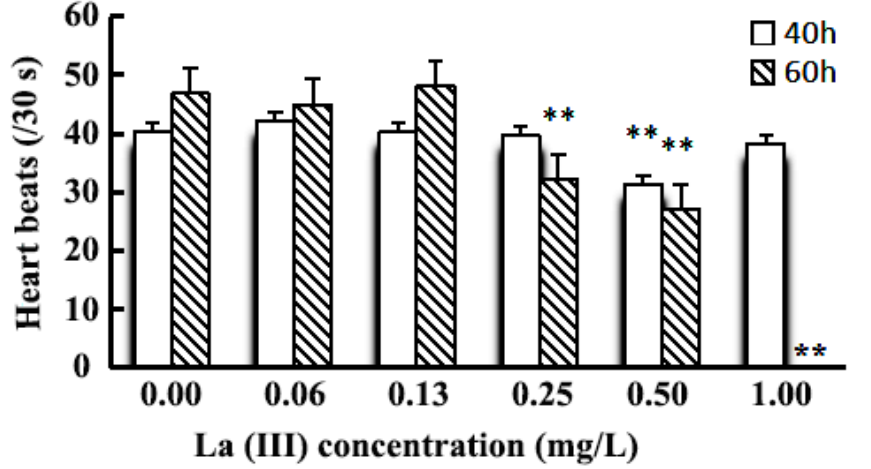
Figure 4. Effects of La (III) on the heart rate of rare minnow embryos. Error bars represent SD. ** Highly significant difference from the control group ( p < 0.01).